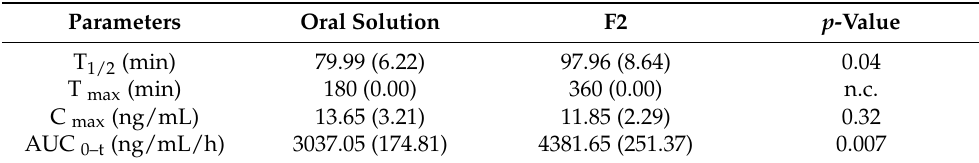
Table 6. HME parameters for developing filaments.